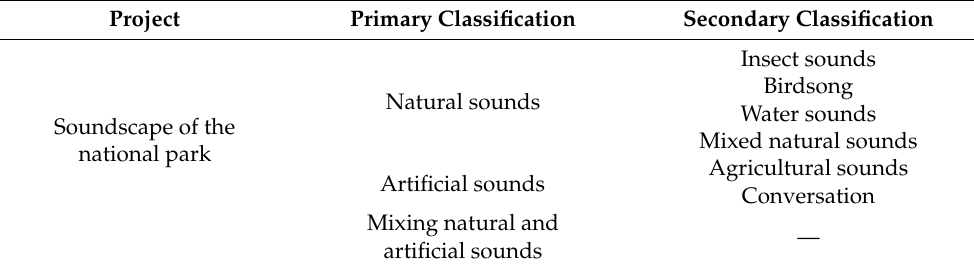
Table 2. The classification of